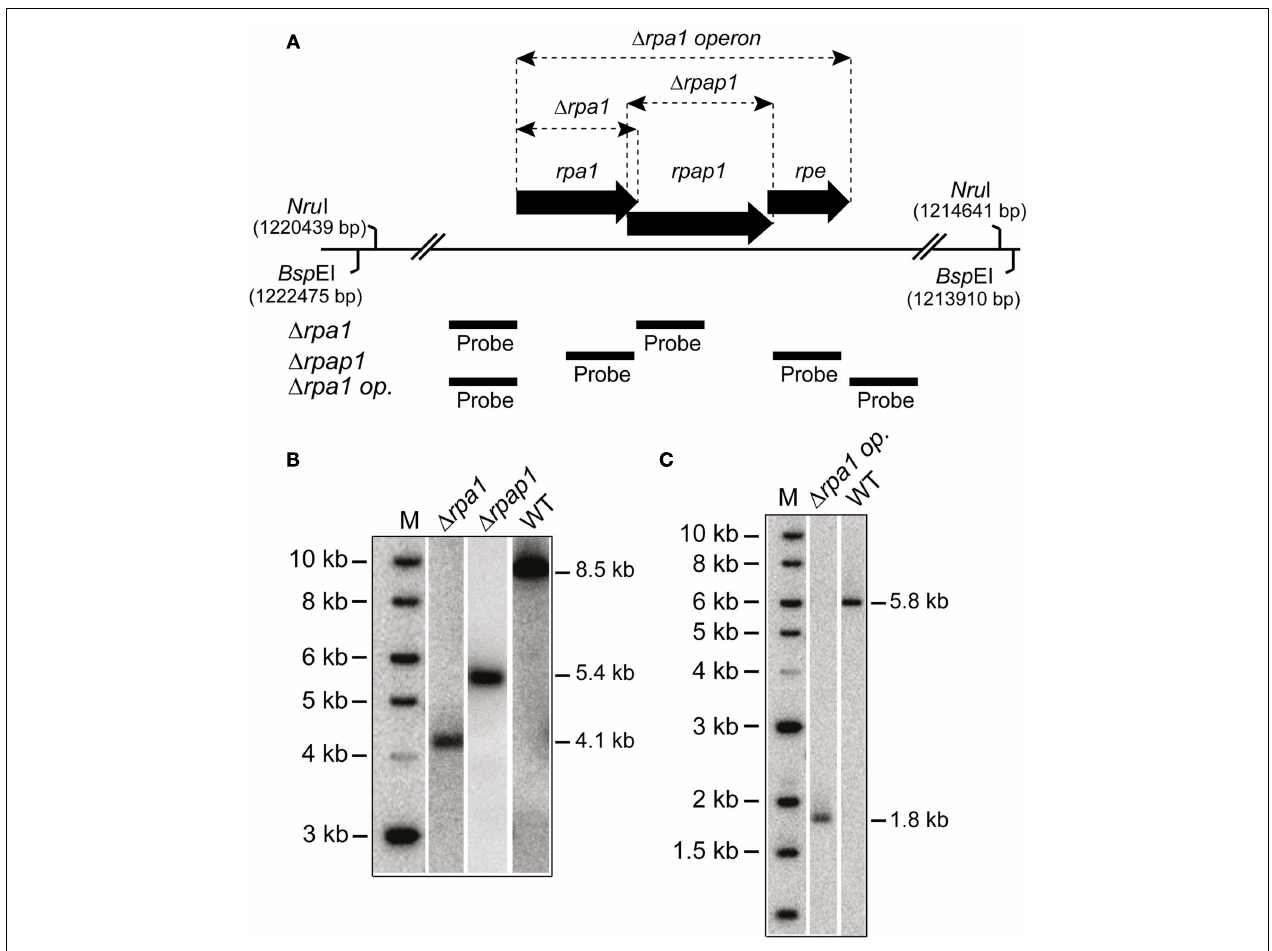
in (A) , to indicate deletion of rpa1 and rpap1 , respectively. (C) Southern blot of genomic DNA cut with Nru I and probed with flanking regions of rpa1 operon ( rpa1 op. ), as shown in (A) , to indicate deletion of the rpa1